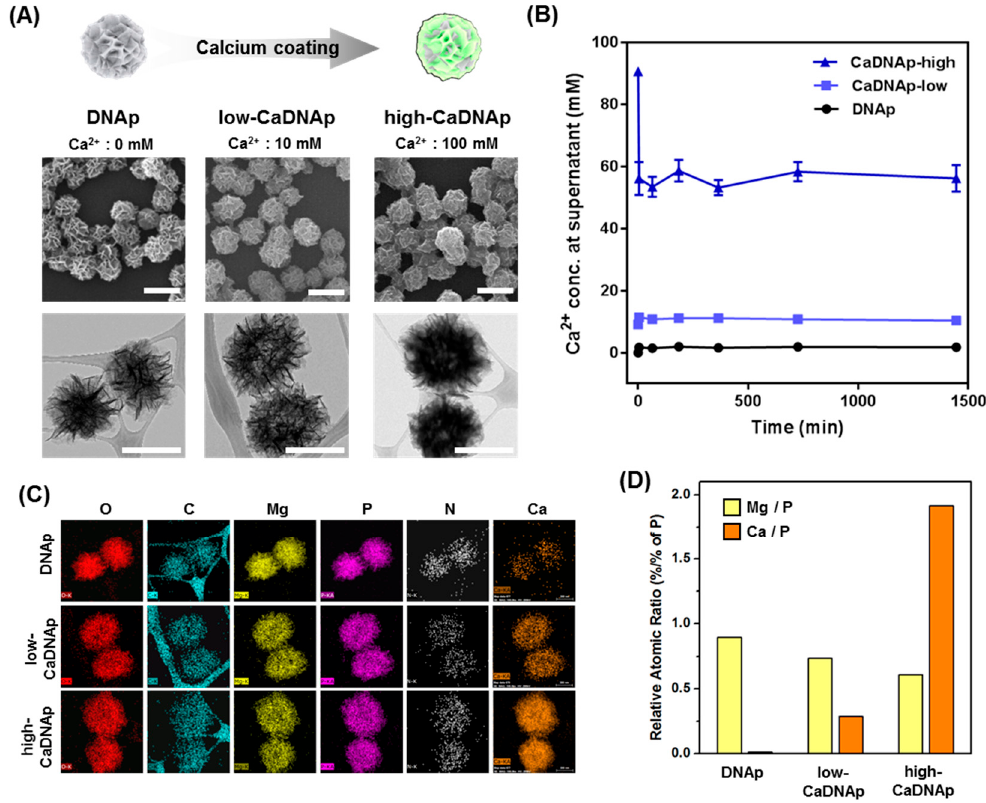
Figure 4. Synthesis and characterization of CaDNAp via Ca 2 + coating of DNAp. ( A ) Schematic illustration for synthesis of CaDNAp ( top ) and SEM ( middle ) and TEM images ( bottom ) of DNAp, low-CaDNAp, and high-CaDNAp (scale bar: 1 µ m). ( B ) Analysis of Ca 2 + content quantification coated on CaDNAp. ( C ) TEM-EDS mapping images of DNAp ( top row ), low-CaDNAp ( middle row ), and high-CaDNAp ( bottom row ). Each element is indicated above the image. ( D ) The atomic ratios of magnesium and calcium to phosphorus for DNAp, low-CaDNAp, and high-CaDNAp. Atomic percentage data were obtained from TEM-EDS.